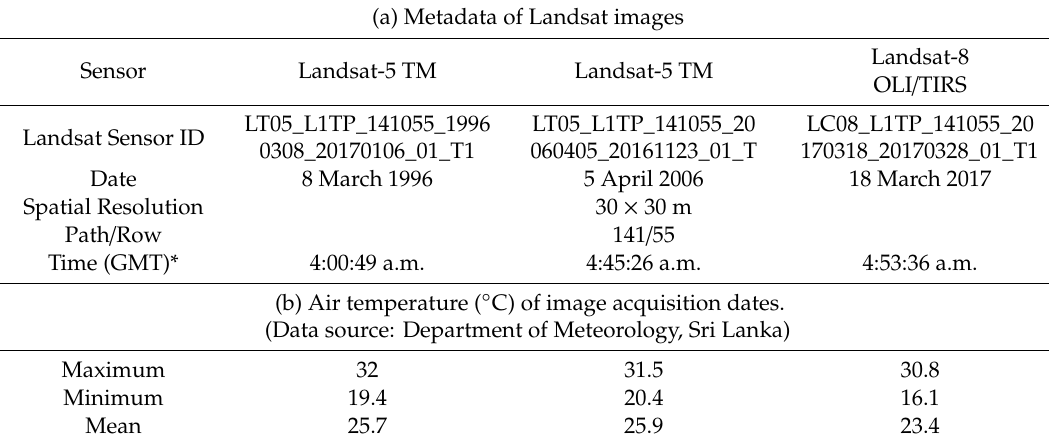
Table 1. Experimental data collection and air temperature of image acquisition dates. TM—Thematic